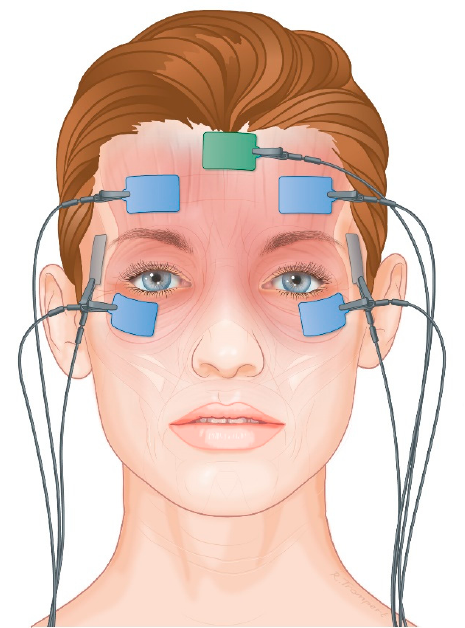
Figure 3. Surface electromyography electrode placement.